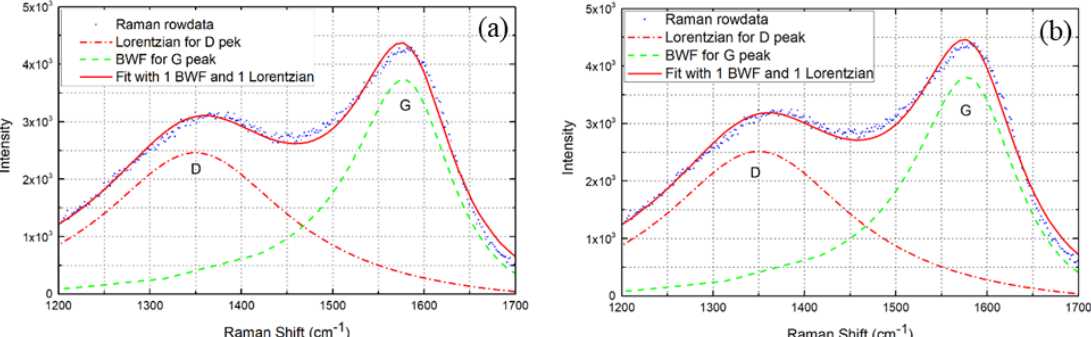
Figure 6. Raman spectra measured on the amorphous carbon thin film deposited by ( a ) Ne and ( b ) Ar. The Raman spectrum is fitted by a Breit-Wigner-Fano line shape and a Lorentzian line shape.